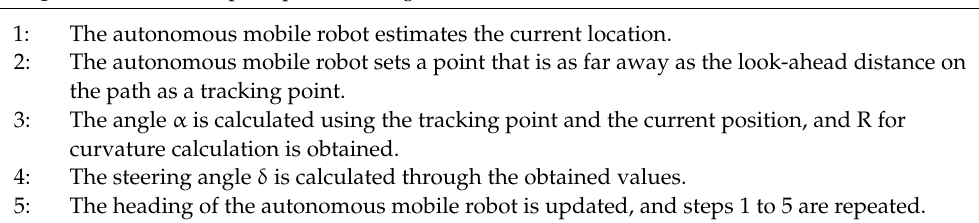
Algorithm 2 Main steps of path